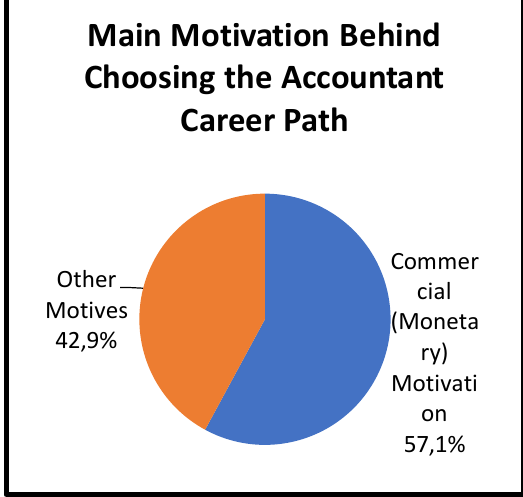
Figure 6. Main Motivation Behind Choosing the Accountant Career Path